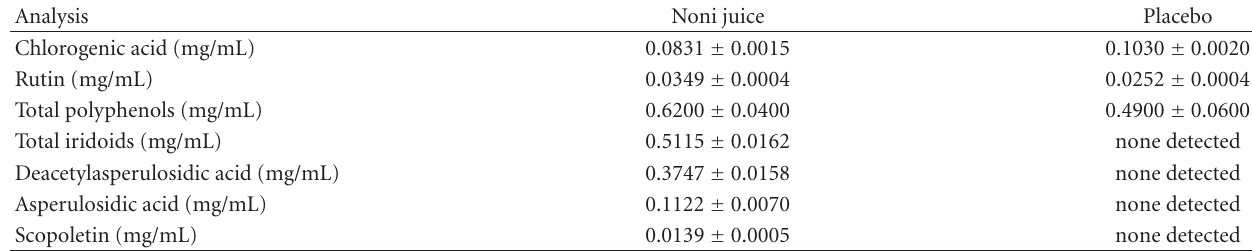
P < 0.05 compared to baseline. Table 4: Phytochemical compositions (mean ± standard deviation) of the noni juice product and placebo evaluated in the clinical trial. Analysis Noni juice Placebo Chlorogenic acid (mg/mL) 0.0831 ± 0.0015 Rutin (mg/mL) Total polyphenols (mg/mL) Total iridoids (mg/mL) 0.5115 ± 0.0162 Deacetylasperulosidic acid (mg/mL) Asperulosidic acid (mg/mL) Scopoletin